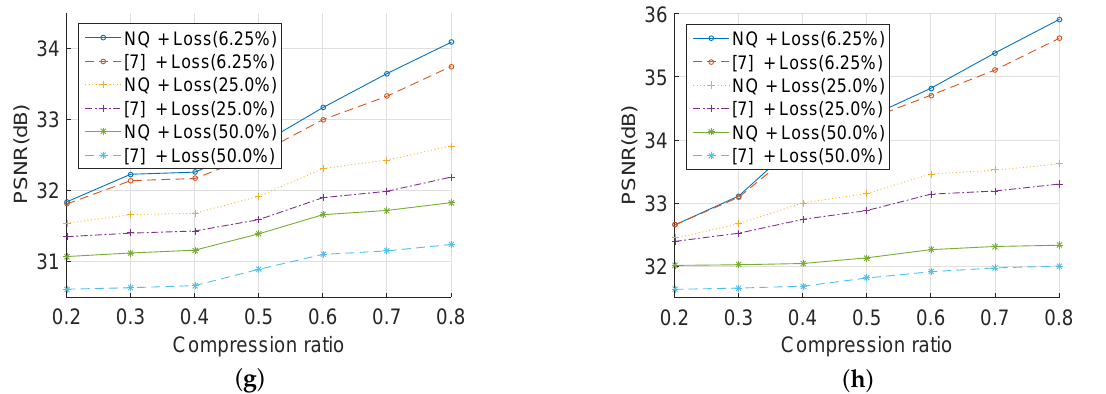
Figure 11. PSNR of decrypted images by the proposed scheme or [7] in different situations. AWGN with zero-mean and with a standard deviation of 40, 60, or 80 in the channel for the images: ( a ) baboon, ( b ) couple, ( c ) bridge, and ( d ) Lena; the data loss is 1/16, 1/4, or 1/2 in the channel for: ( e ) baboon, ( f ) couple, ( g ) bridge, and ( h )